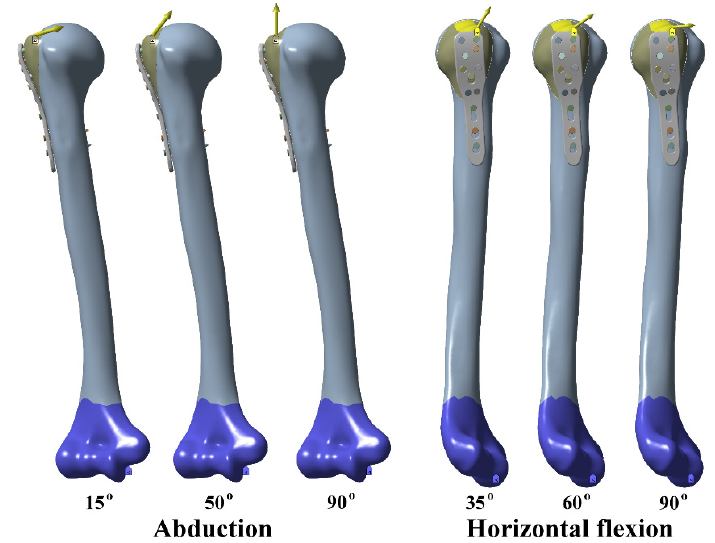
Figure 2. Finite element models under mechanical testing